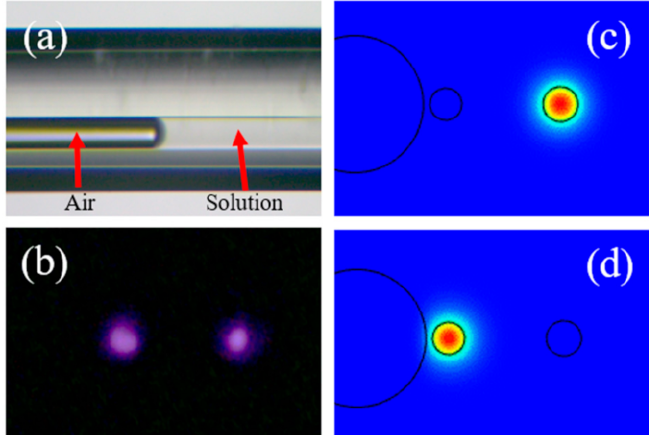
Figure 2. ( a ) Interface between the glycerol–water solution and the air in the channel of the DCF; ( b ) Guided modes of DCF experimentally visualized by an infrared camera; ( c ) LP 01 mode simulation in the eccentric core in the solution-filled DCF; ( d ) LP 01 mode simulation in the central core in the solution-filled DCF.